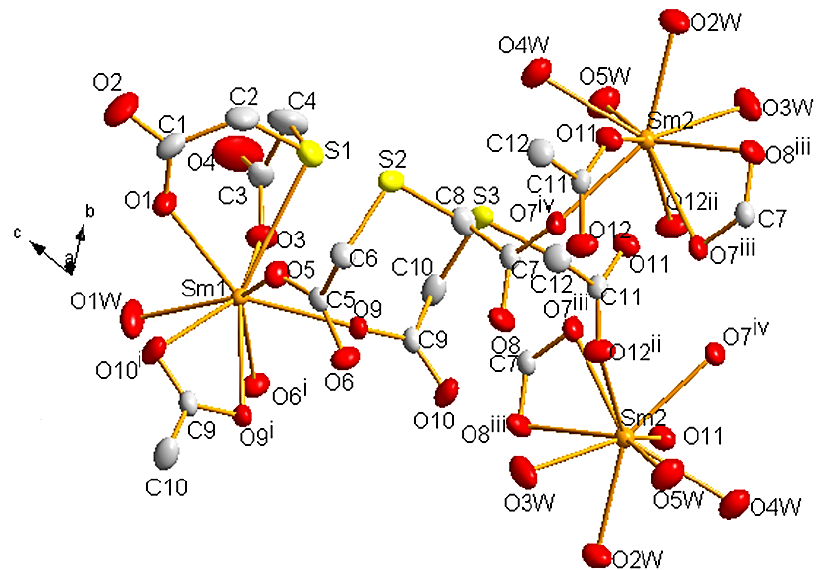
Figure 2. Perspective drawing of 1 showing the atom labels. Thermal ellipsoids are plotted at the 50% probability level. Hydrogen atoms and crystallization water molecules are omitted for clarity. Color code: Sm, orange; C, light grey; O, red; S, yellow. The symmetry-related atoms were obtained by applying the symmetry codes i 1 − x, −y, 1 − z; ii −x, 1 − y, −z; iii 1 − x, 1 − y, −z; iv −1 + x, +y, +z. Table 3. Bond lengths (Å) around central atom for 1 and 2 .